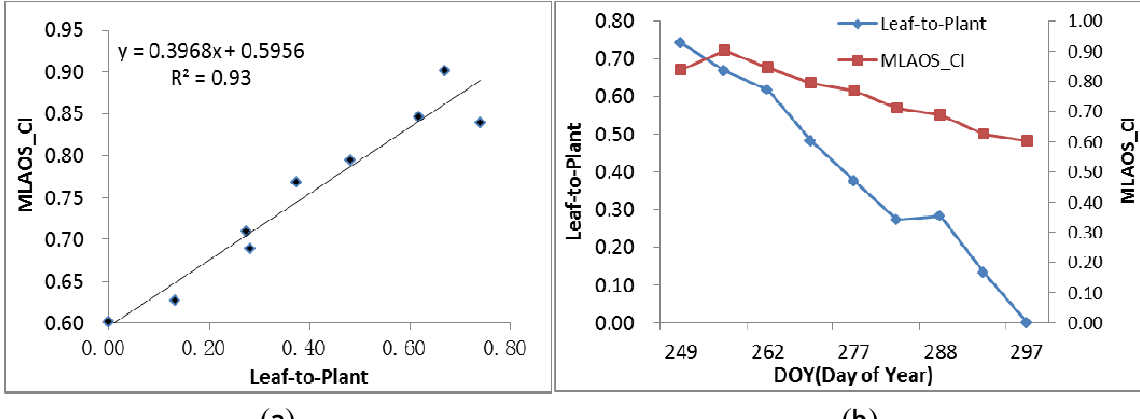
Figure 11. A Comparison the CI and Leaf-to-Plant relationship. ( a ) The scatter of the two variables; ( b ) Their changes in a temporal